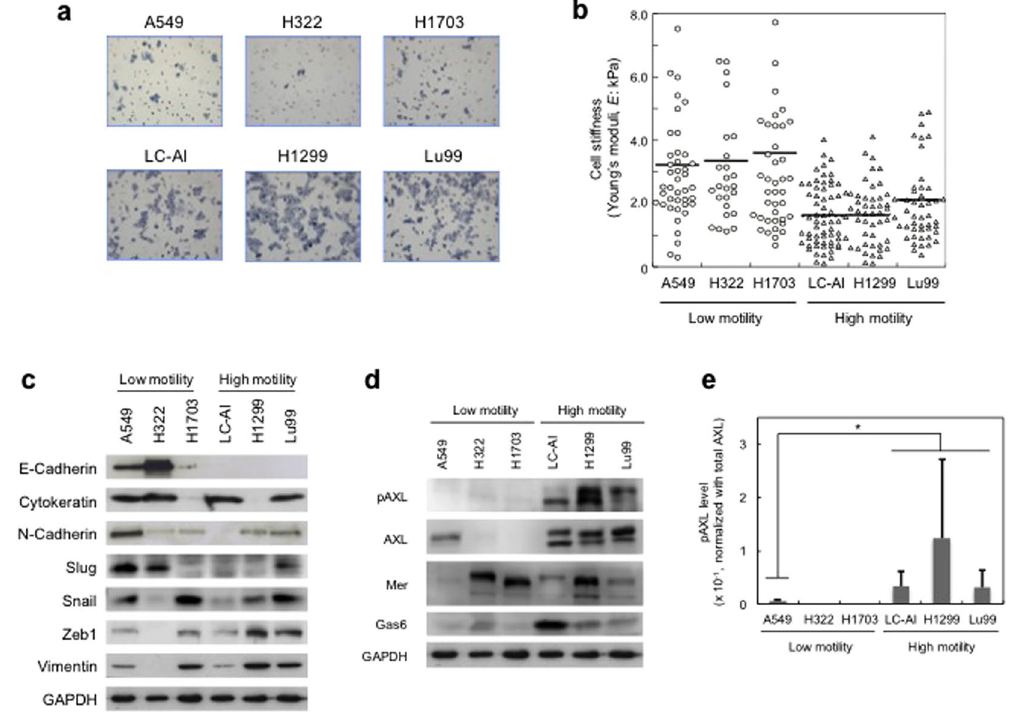
Figure 1. Involvement of AXL tyrosine kinase in cell motility and stiffness of NSCLC. ( a ) Cell motility of six cell lines showing migrated cells attached to the membrane in the presence of 5 µ g/ml fibronectin. ( b ) Young’s moduli were determined in six cell lines by AFM. Each dot indicates Young’s modulus of one cell. The low motility cell lines (A549, H322 and H1703) ( ○ ) showed wide distribution of Young’s moduli, and the high motility cell lines (LC-AI, H1299 and Lu99) ( △ ) showed narrow distribution of Young’s moduli. Bars indicate median values of Young’s moduli. ( c ) Western blot analysis of EMT-related protein levels in the six cell lines. Western blotting was conducted in at least three independent experiments, and similar results were obtained. ( d ) Western blot analysis of EMT-related receptor tyrosine kinases (AXL and Mer) and Gas6 ligand in the six cell lines. ( e ) Quantitation of pAXL levels in the six cell lines, normalized with total AXL (n = 3) (mean ± s.d.). * p <